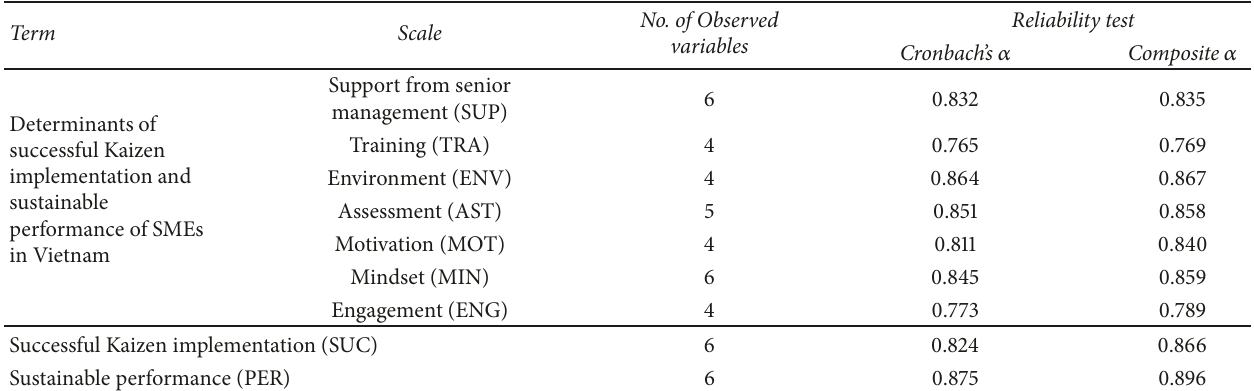
Table 6: Confirmatory factor